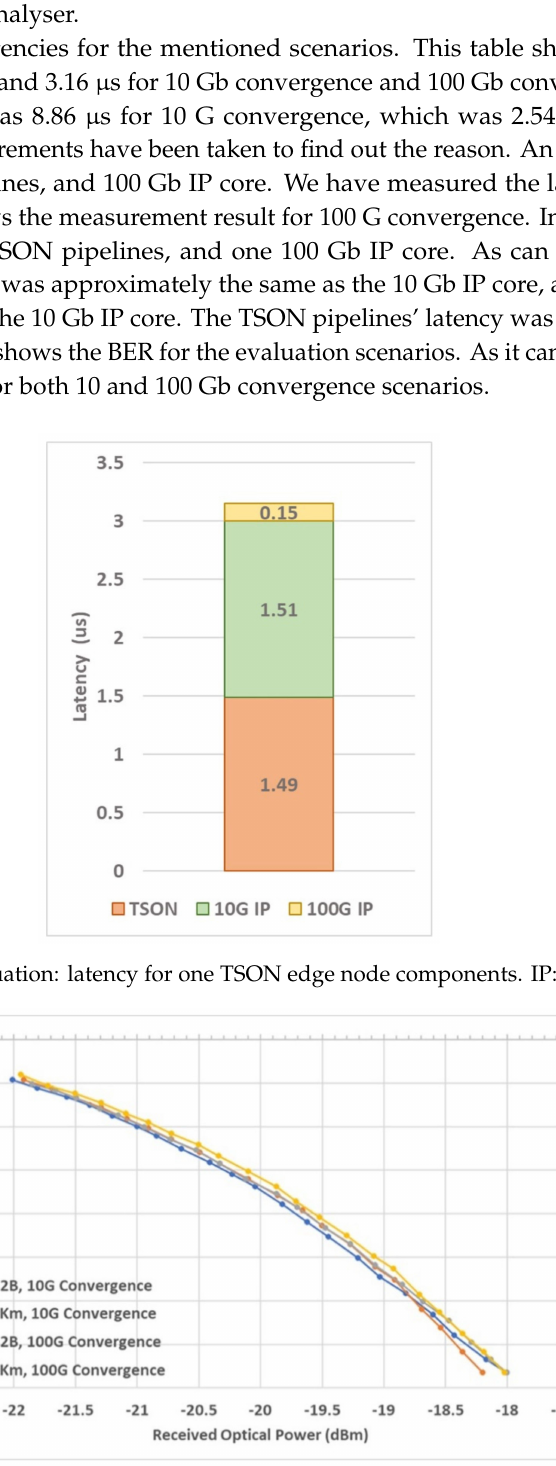
Figure 16. Performance evaluation: bit error rate (BER) for di ff erent evaluation scenarios. B2B: back to